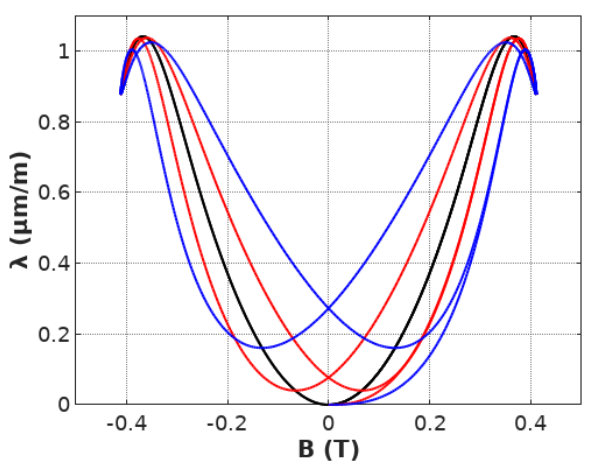
µ m µ m 1 1 , a 2 = − 90.9 , 1 , a 2 = −90.9 m m T T 2 𝑚 𝑇 2